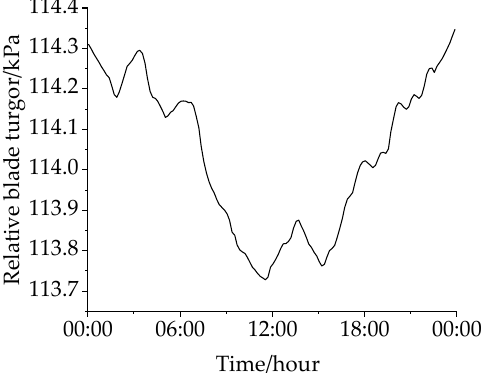
Figure 11. Turret pressure curve under high water stress.